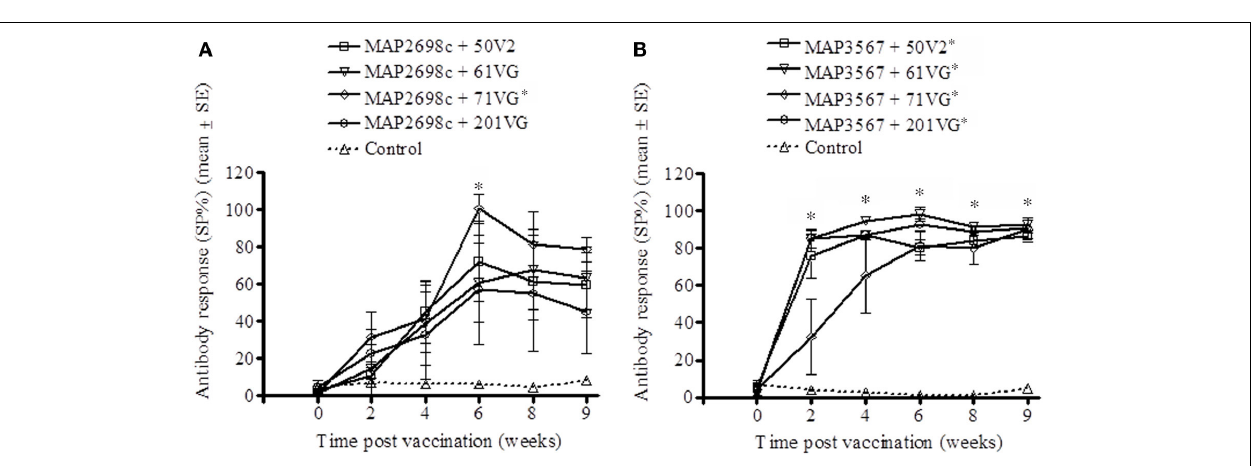
FIGURE 3 | MAP 316v antibody responses of serum from sheep vaccinated with the different formulations of recombinant antigen vaccines. (A) MAP 316v antibody responses in sheep vaccinated with